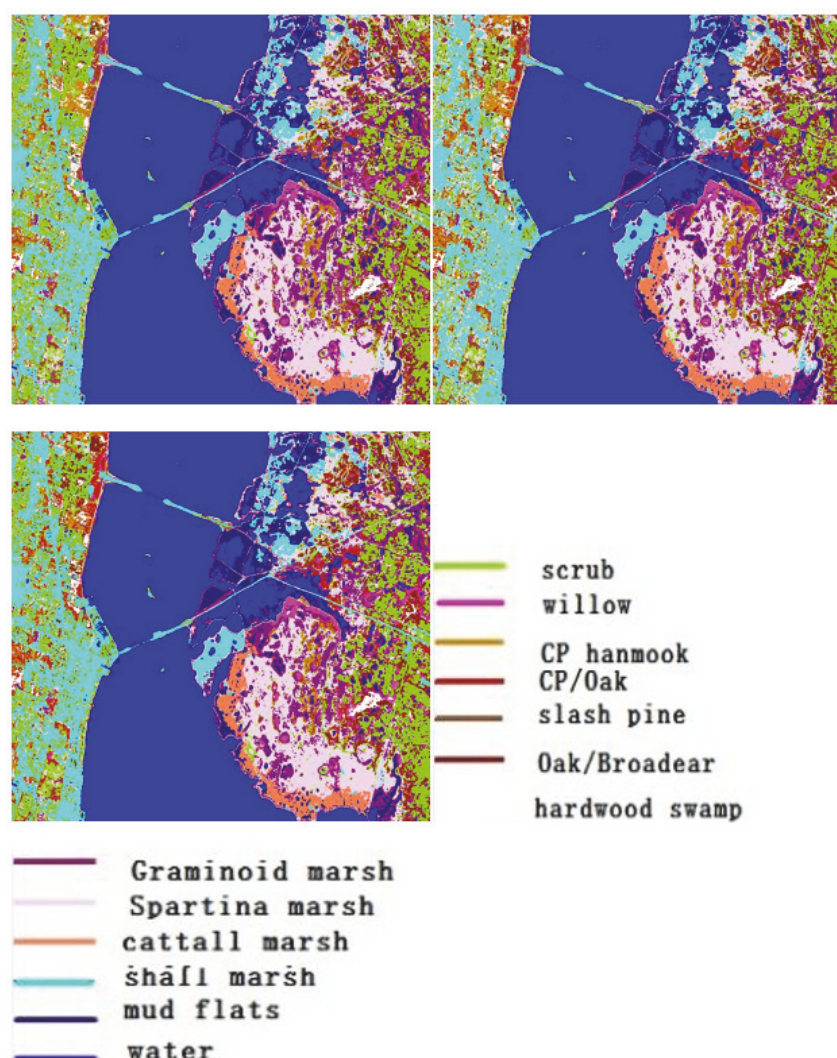
Figure 16: The classification results of CART algorithm for AVIRIS